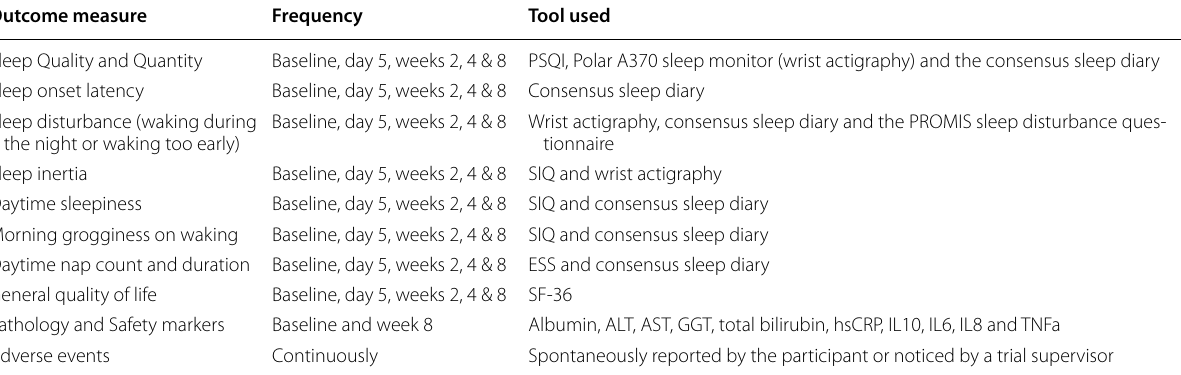
Table 1 Outcome Measures Outcome